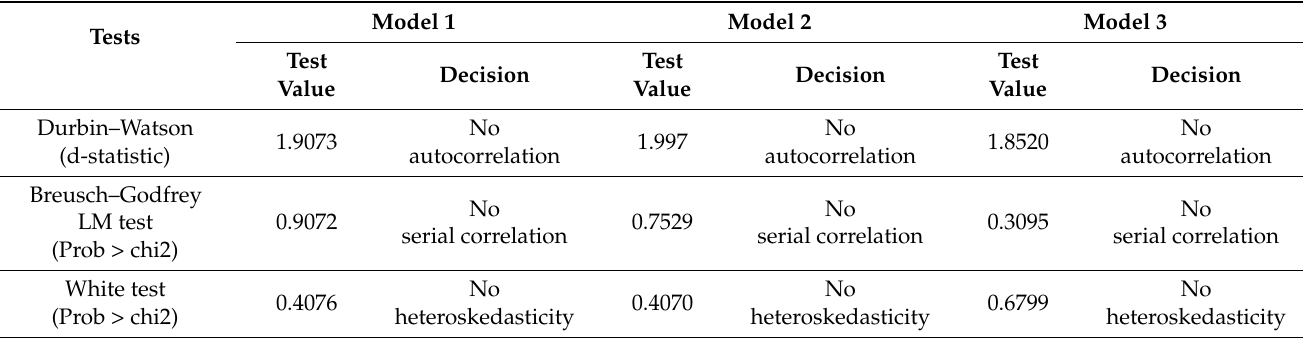
Table 7. Diagnostic test results.